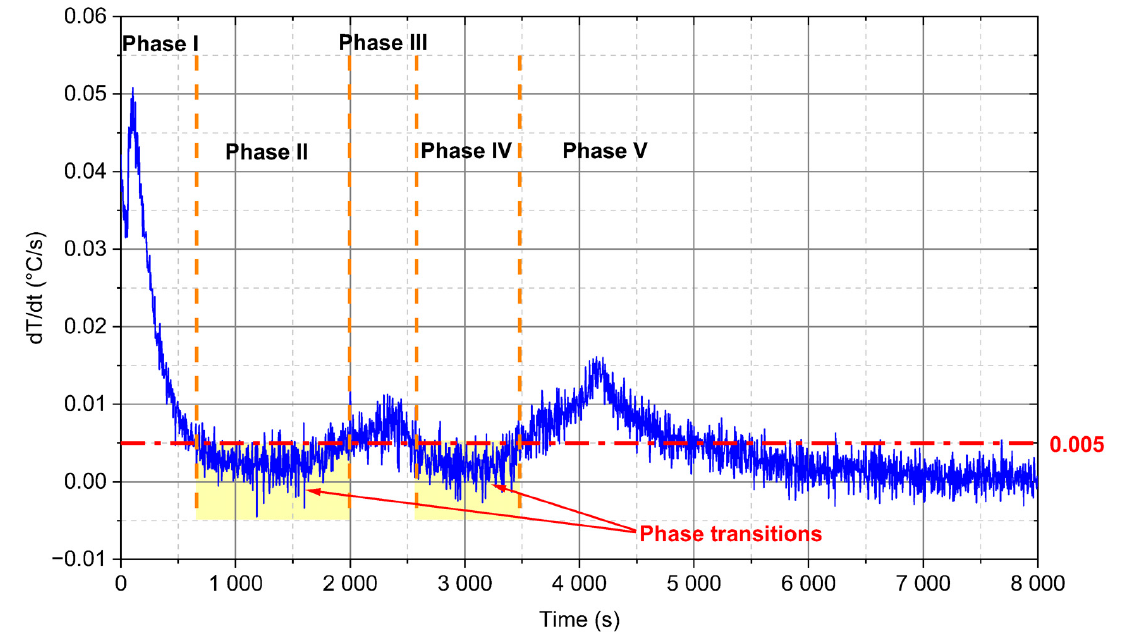
Figure 11. Derivation evolution of T 3 thermocouple for d = 28 mm PCM module and 0.92 m/s value of the